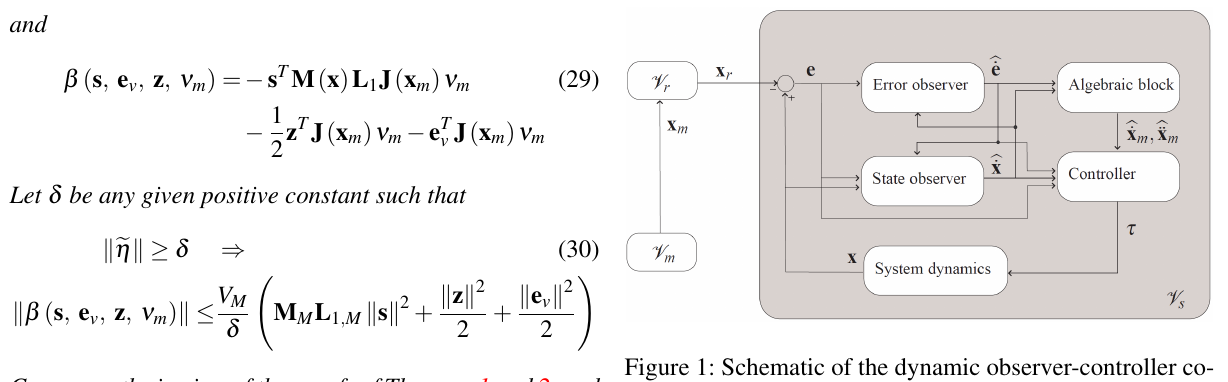
Figure 1: Schematic of the dynamic observer-controller co- ordination control system of the follower V s